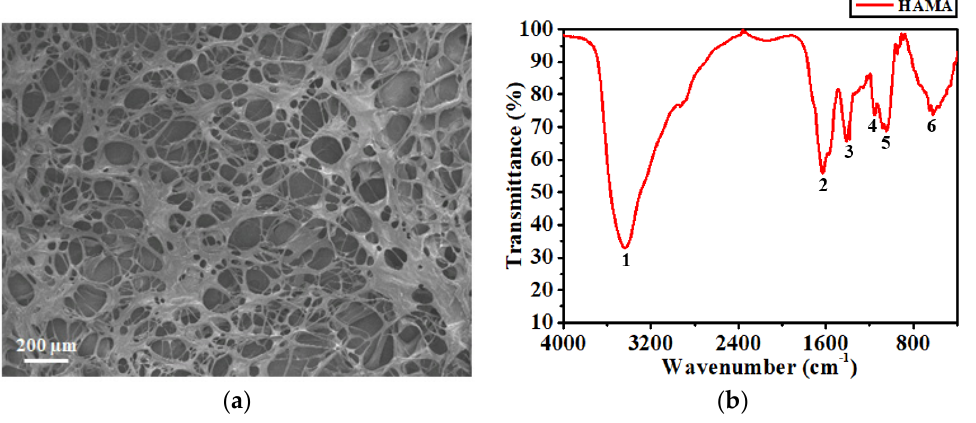
Figure 3. ( a ) Cross-sectional SEM image and ( b ) FTIR spectrum of the synthesized HAMA hydrogel. The numbers in ( b ) denote the prominent peaks detected by the FTIR analysis.